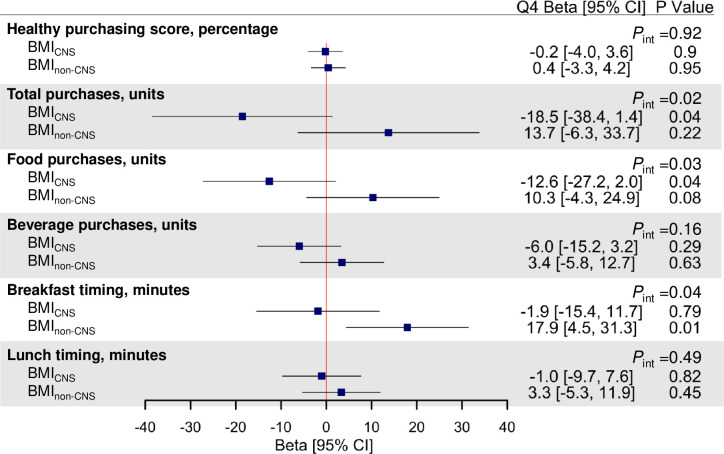
BMICNS and BMInon-CNS genetic scores associations with quality, quantity, and timing of workplace purchases.Association results are adjusted betas reflecting difference in Healthy Purchasing Score (percentage), items purchased (units over 3-month period), or timing (in minutes) between highest (Q4) and lowest (Q1, reference) quartile of BMI genetic scores adjusted for age, sex, seasonality, and 5 principal components of ancestry. Higher purchasing score = healthier purchases (0%–100%). For interpretation purposes, adjusted betas are from models in which outcomes are untransformed, whereas P values are derived from models in which outcomes are inverse normalized. P values are unadjusted for multiple testing, and false discovery rate–corrected P values (Padj) are presented in S2 Table. Based on the biological functions of genes in or near the 97 previously identified BMI loci, the BMICNS PRS and BMInon-CNS PRS comprise 54 variants previously classified as CNS-related and 43 variants previously classified as non-CNS-related, respectively. BMI, body mass index; CI, confidence interval; CNS, central nervous system; GPS, genome-wide polygenic score; int, interaction; PRS, polygenic risk score.